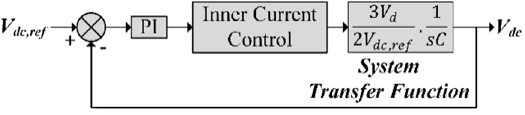
Figure 8. Output DC voltage control loop of the VSC.